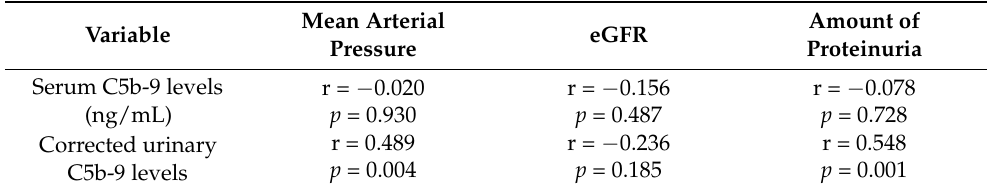
Table 2. Relationship between baseline serum and corrected urinary C5b-9 levels and conventional risk factors at presentation in patients with IgA nephropathy.